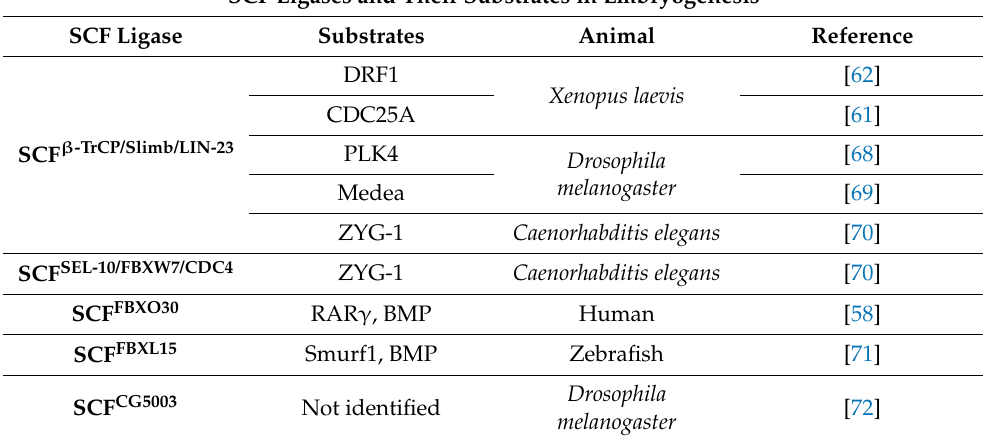
Table 2. Known SCF ligases and their substrates in embryogenesis of human, Xenopus , C. elegans , Drosophila and zebrafish